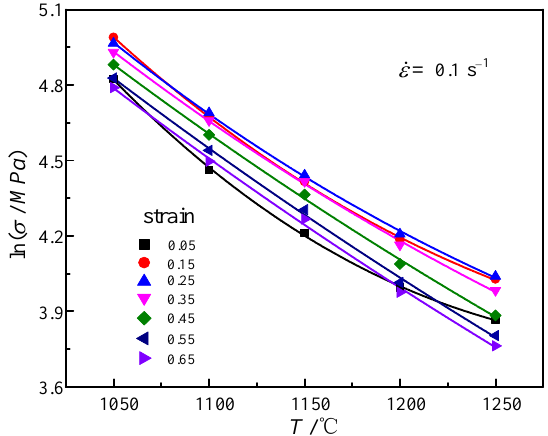
Figure 6. Relationships between ln σ and T at 0.1 s − 1 . When temperature and strain rate are constant, ln A + m 1 T + m 3 ln m 9 ln T to K 4 is set to get the following formula (8):